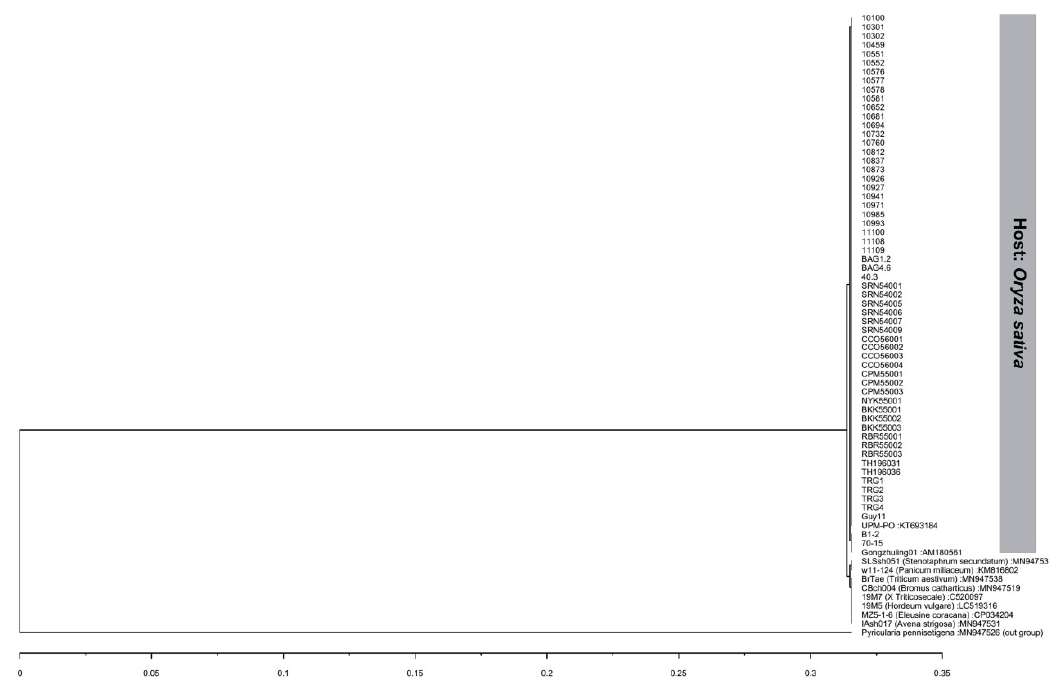
Figure 4. Dendrogram based on the internal transcribed spacer (ITS) of the 59 isolates used in this study compared to the reference Pyricularia oryzae sequences from different hosts obtained from GenBank based on UPGMA cluster analysis. Hosts are specified in parentheses, and GenBank accession numbers are provided following the colon.